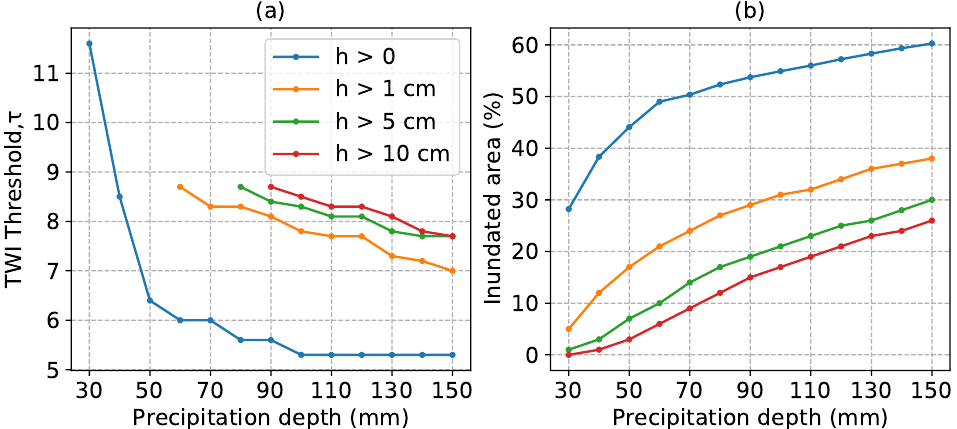
Figure 11. ( a ) TWI threshold ( τ ) for different water depth thresholds (h). ( b ) Percentage of inundated areas for different water depth thresholds (h).